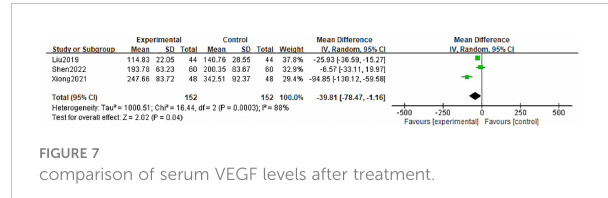
FIGURE 7 comparison of serum VEGF levels after treatment.